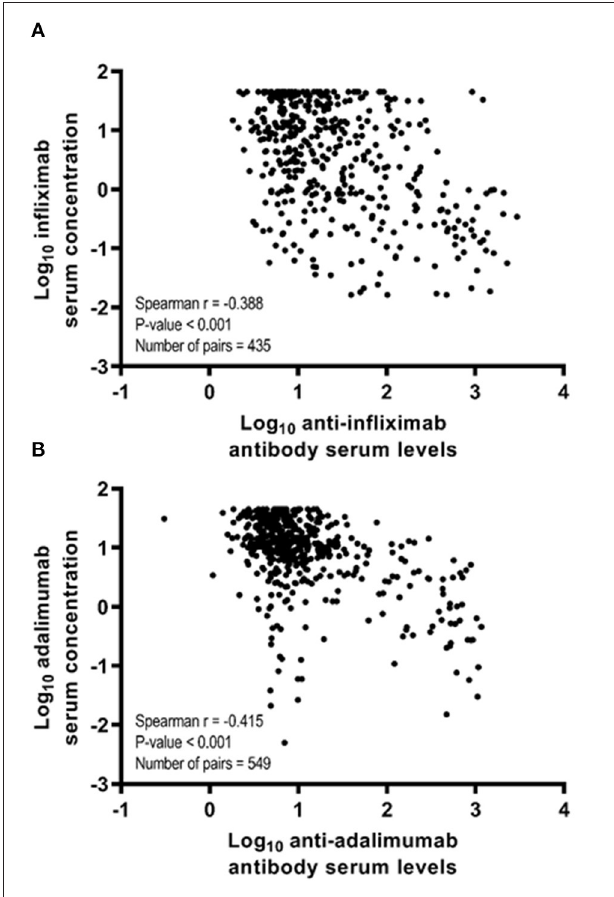
FIGURE 2 | Spearman correlation coefficients (r) between anti-drug antibody levels and anti-TNF therapy serum drug concentration according to anti-TNF therapy in the total study sample. (A) Spearman correlation coefficient between log 10 -transformed infliximab serum concentration and log 10 -transformed anti-infliximab antibody serum levels. (B) Spearman correlation coefficient between log 10 -transformed adalimumab serum concentration and log 10 -transformed anti-adalimumab antibody serum